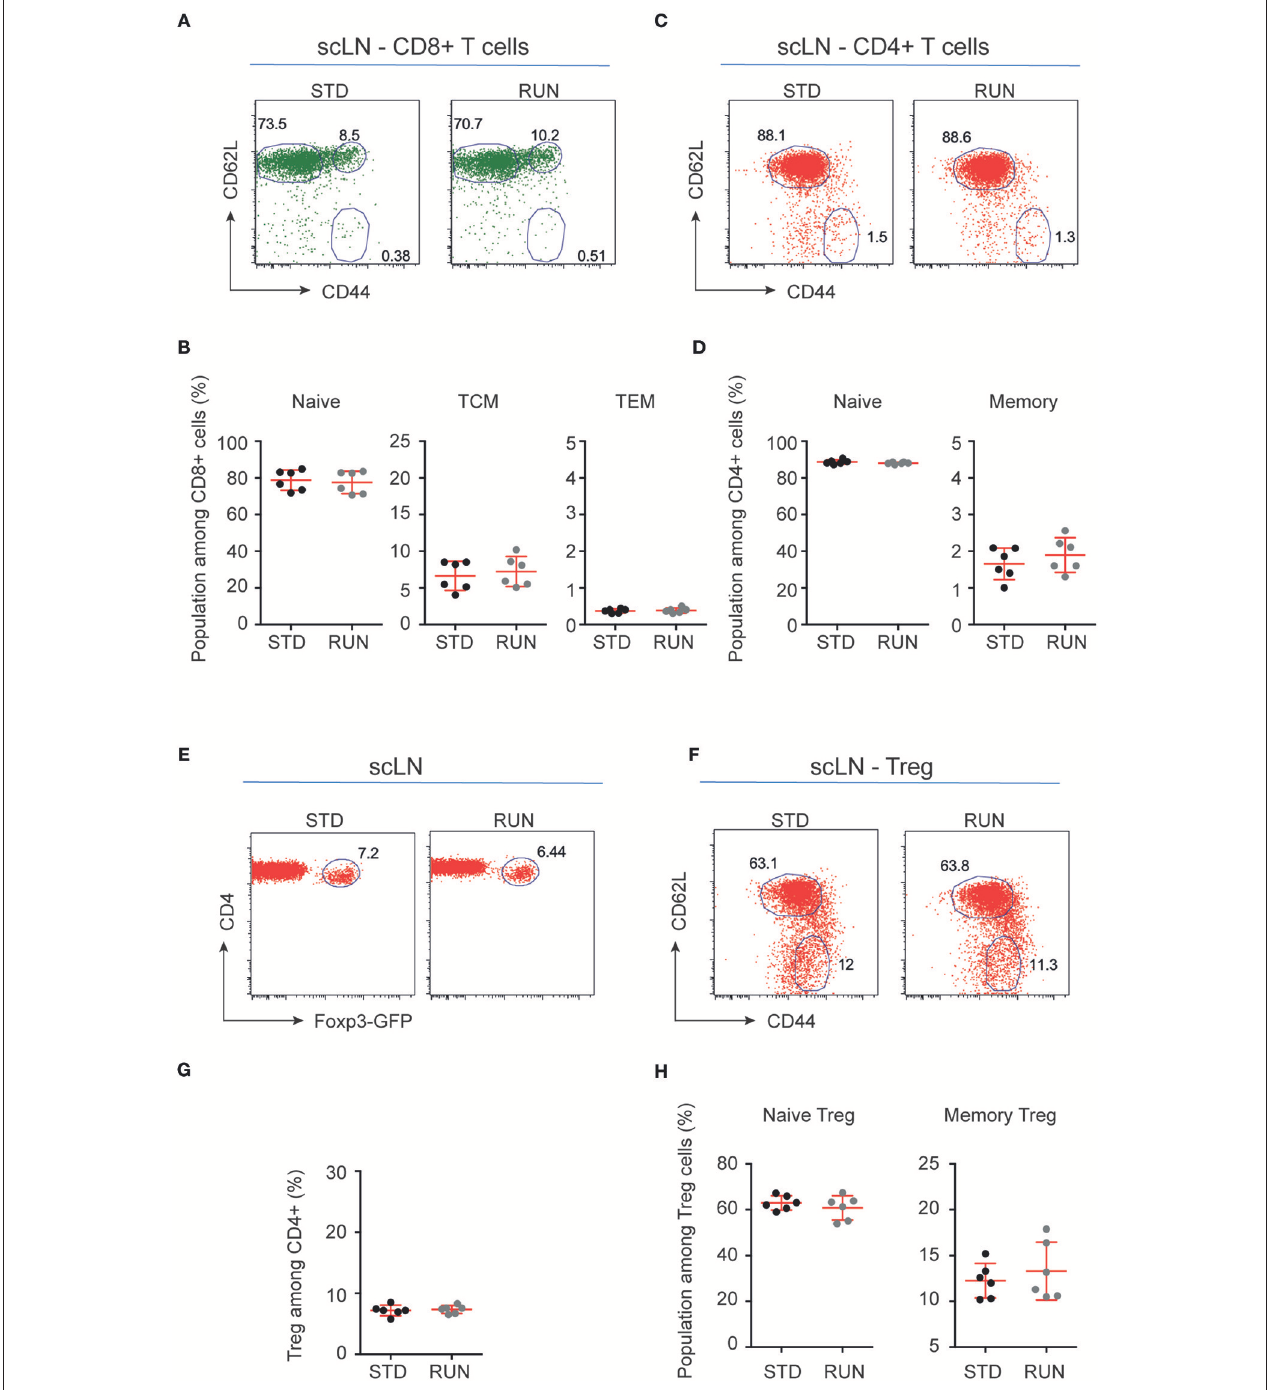
FIGURE 6 | Maturation stages of CD8 + and CD4 + T cells and Tregs in the subcutaneous lymph nodes of STD and RUN mice . (A,C) Representative dot plots of CD62L and CD44 expression on CD8 + (A) and CD4 + (C) T cells in the subcutaneous lymph nodes (scLN) of mice that were housed under STD or RUN conditions. (B) Composite frequencies of naive, central memory (TCM) and effector memory (TEM) T cells among CD8 + T cells in the scLN. (D) Composite frequencies of naive and memory T cells among CD4 + T cells in the scLN. (E) Representative dot plots depicting the expression of Foxp3-GFP among gated CD4 + T cells in the scLN of mice that were housed under STD or RUN conditions. (G) Composite frequencies of Foxp3 + Tregs among CD4 + T cells in the scLN. (F) Representative dot plots depicting the expression of the maturation markers CD62L and CD44 on Foxp3 + Tregs. (H) Composite percentages of naive and memory Tregs in the scLN of STD and RUN mice after 4 days of running. Numbers in dot plots in (B,D,G,H) indicate the percentages of cells within the respective gate. Symbols and horizontal lines indicate individual mice and mean values ± SD, respectively. The level of significance was determined by a two-tailed Mann Whitney test. Data were compiled from two independent